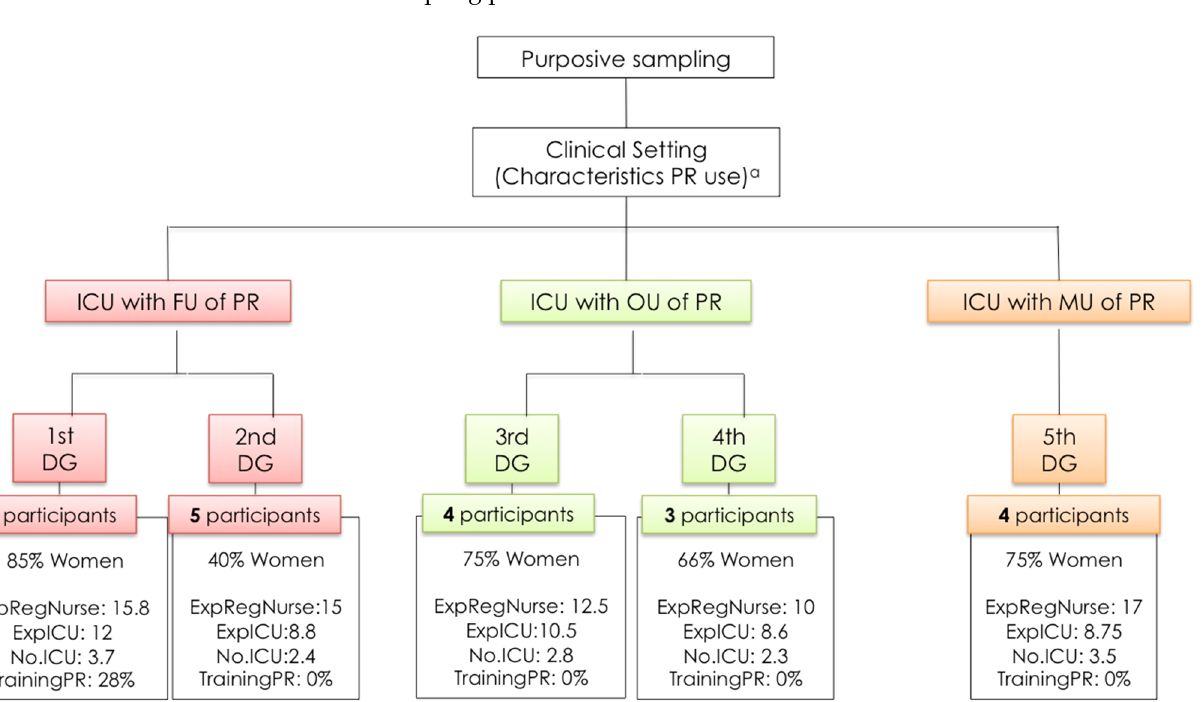
Figure 3. Characteristics of discussion groups according to population criteria and sampling procedures—Registered Nurses. a Conceptual hypothesis: clinical settings and their organizational cultures influence conceptualizations of PR use. Abbreviations: PR: physical restraint; ICU: intensive/critical care units; FU: frequent/systematic use; OU: occasion- al/individualized use; MU: mixed use; DG: discussion group; ExpRegNurse: years of work experience as a registered nurse; ExpICU: years of work experience in intensive/critical care units; No.ICU: number of intensive/critical care units other than those where they pursued their professional activity; TrainingPR: percentage of participants with specific training in physical restraints, not necessarily in a critical care setting.